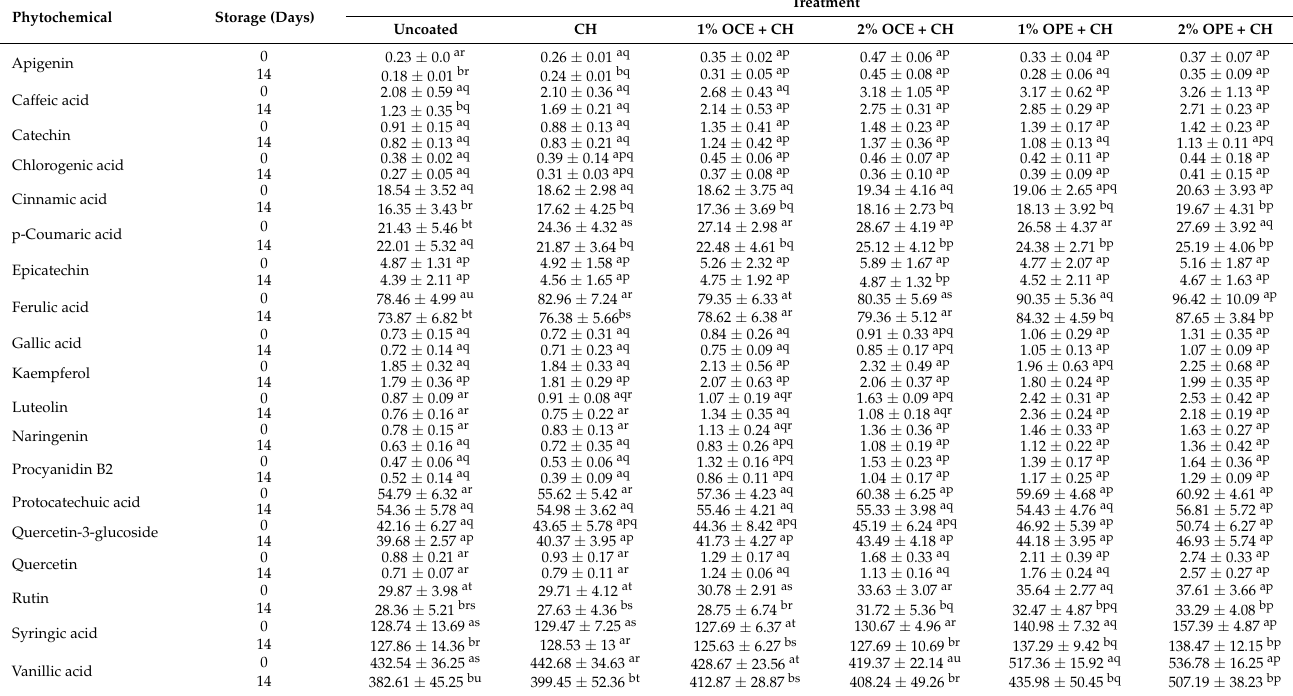
Table 2. Polyphenolic Compound (Phenolic Acids and Flavonoids) Amounts (mg/kg) in Barhi dates coated with chitosan (CH) and/or olive-cake extract (OCE) or orange-peel extract (OPE) during refrigerated